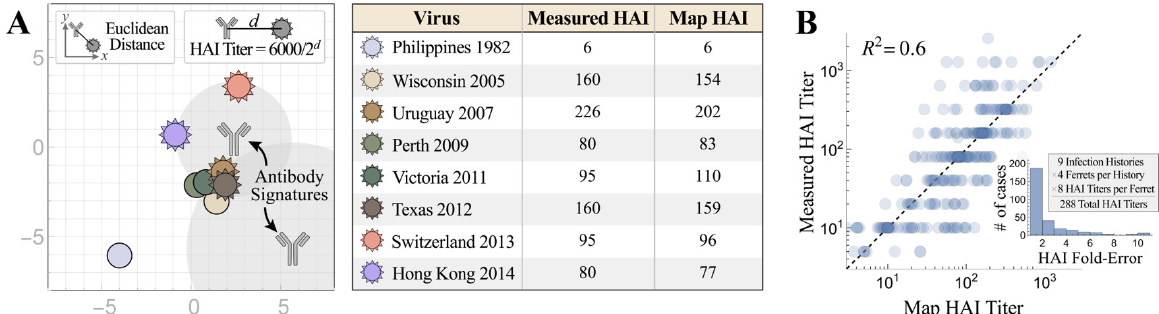
4 of 13 4.1. Validation of Neutralization Landscapes Neutralization Landscapes uses fixed virus coordinates to depict the location and magnitude of constituent neutralizing antibodies within an antiserum elicited by natural infection or vaccination [29]. A key assumption of Neutralization Landscapes is that the neutralization profiles of all dominant antibodies within a serum can be represented as